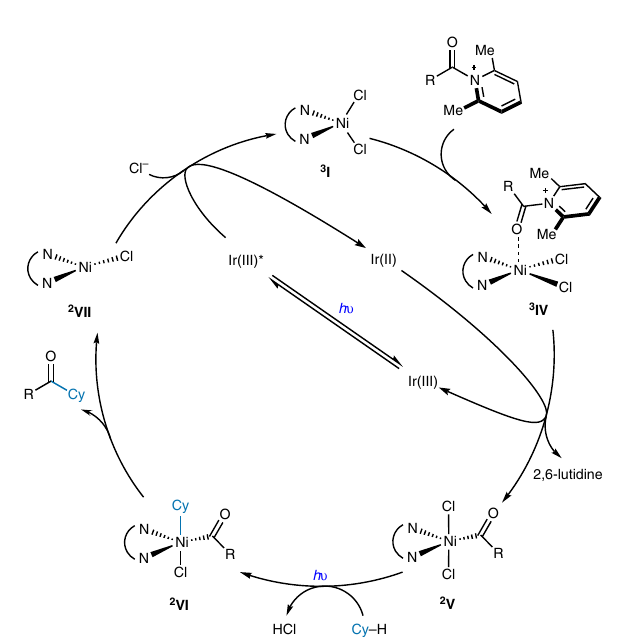
Fig.6|Computedfreeenergypro fi lefortheoverallreactionwithsubstrate2z. The computed reaction pro fi le demonstrates facile reduction of 3 IV followed by